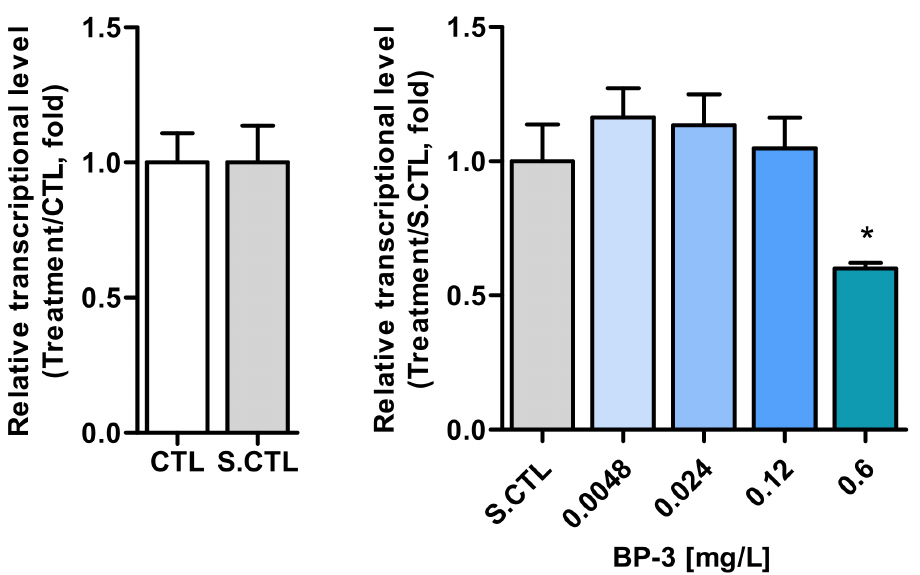
Figure 1. Relative transcriptional level of vtg1 in the liver of Cyprinus carpio exposed to benzophenone- 3 for 21 days. No difference between blank and solvent controls were shown. All treatments were compared to a solvent control. Data are presented as mean ± SD and were statistically analyzed using a one-way ANOVA post hoc Dunnett’s multiple comparison test ( p < 0.05 ): * p < 0.05.